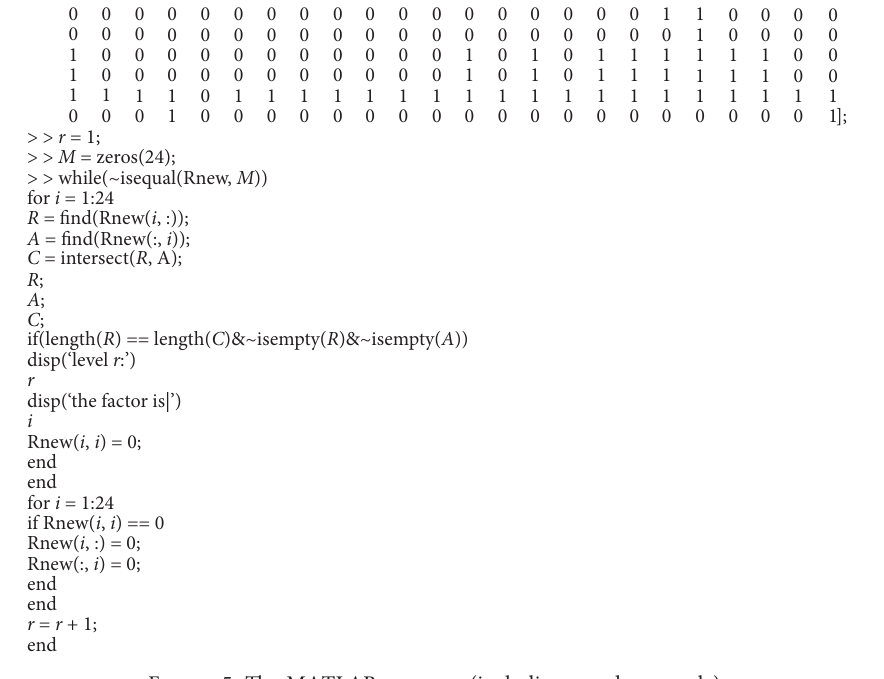
Figure 5: The MATLAB program (including a code example). Table 5: Reachability matrix (including initial and final).